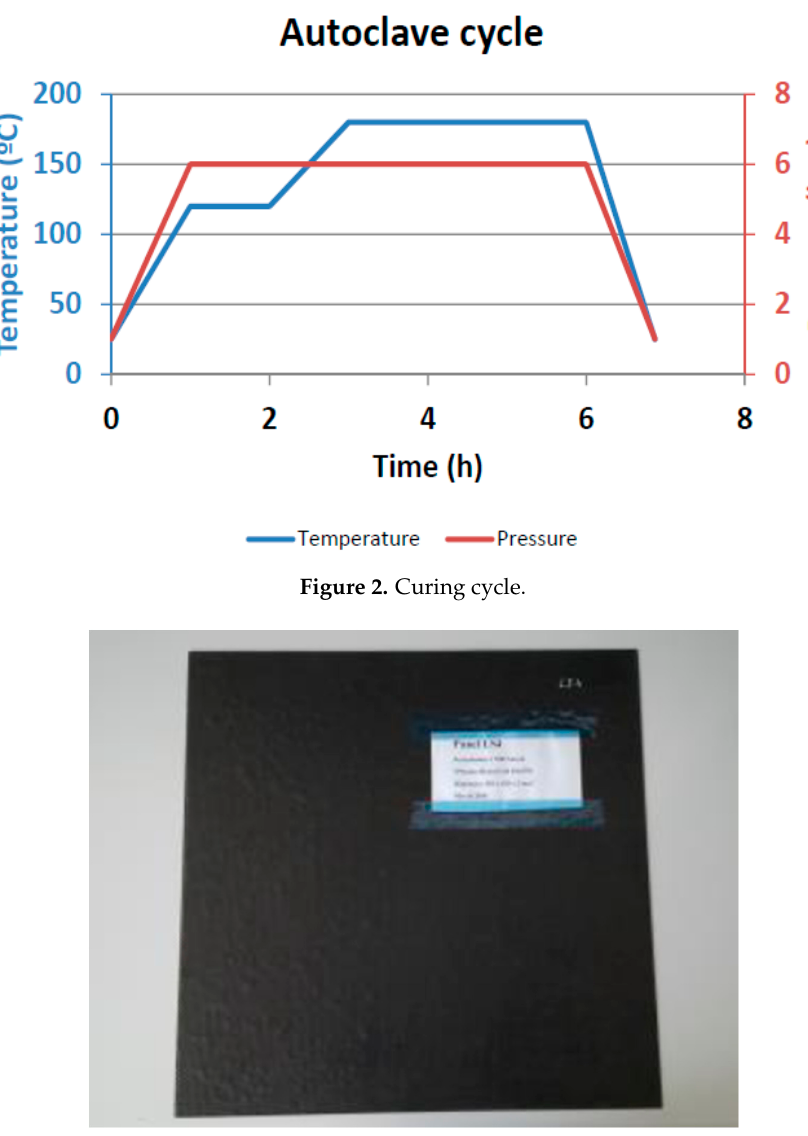
Figure 3. Manufactured panel.